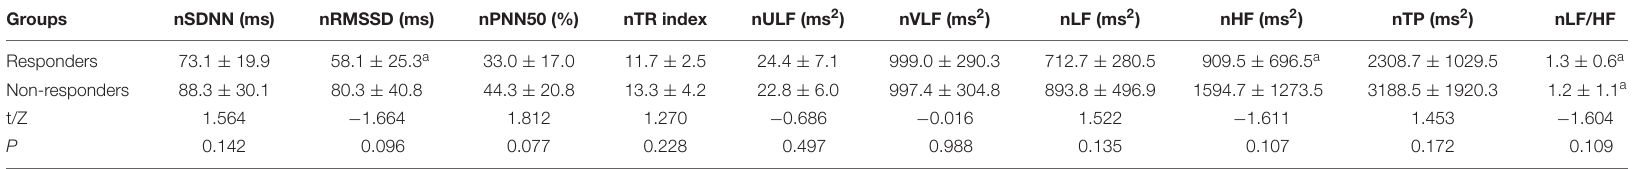
HRV, Heart rate variability; nSDNN, night standard deviation of all NN intervals during 24-h recording; nRMSSD, night root mean square of the successive NN interval difference; npNN50, night percentage of adjacent RR intervals > 50 ms; nTR index, night triangular index; nULF, night ultra low frequency; nVLF, night very low frequency; nLF, night low frequency; nHF, night high frequency; nTP, night total power; nLF/HF, night ratio of low to high frequency power. Data are mean ± SD. a Non-normal